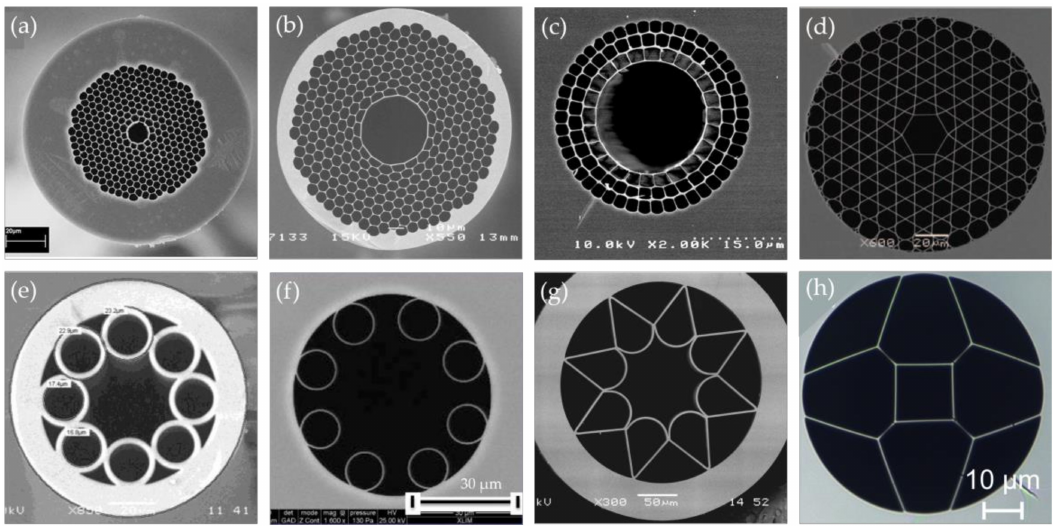
Figure 6. Scanning electronic microscopy (SEM) images of some representative hollow-core photonic crystal fibers (HC-PCFs): ( a ) Commercial available hollow core photonic bandgap fiber (HC-PBGF): HC-1550-02 from NKT Photonics [138]; ( b ) HC-PCF designed for the guiding in the MIR region